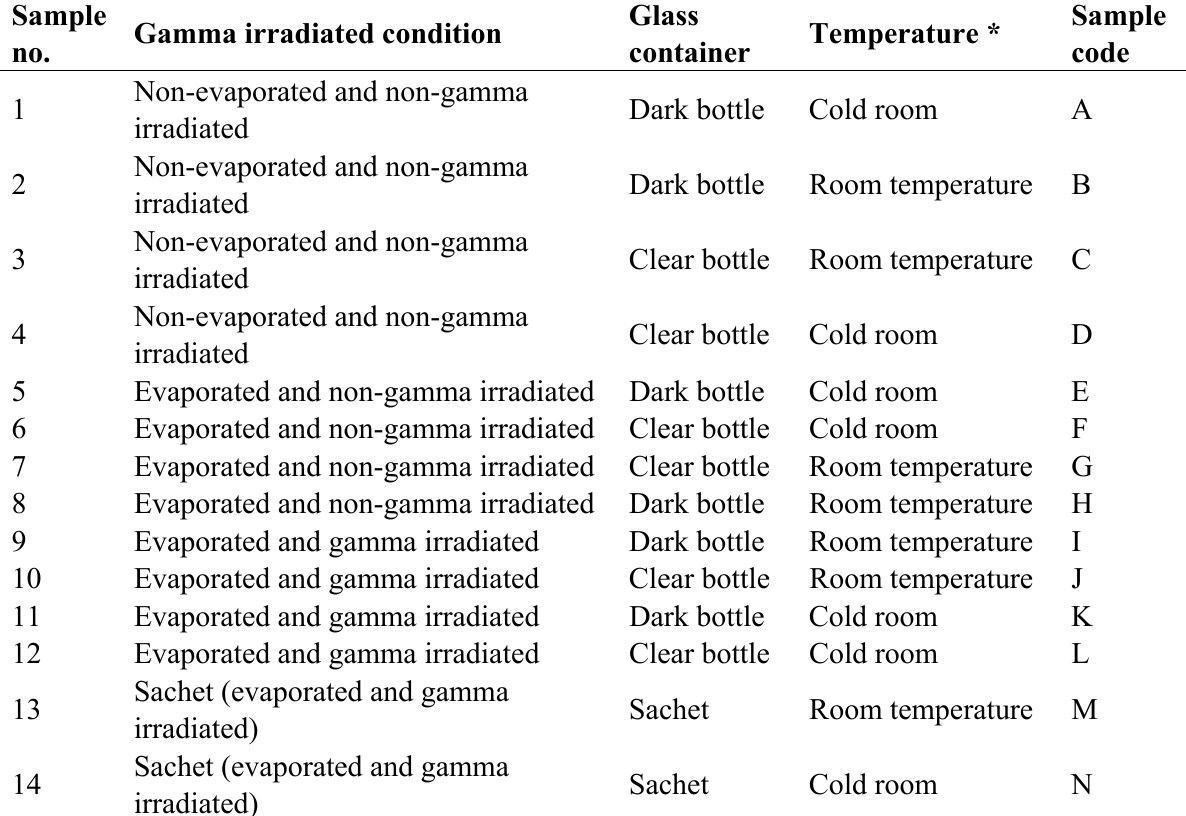
Table 1. Storage conditions (gamma irradiation, evaporation, container and temperature) for each honey